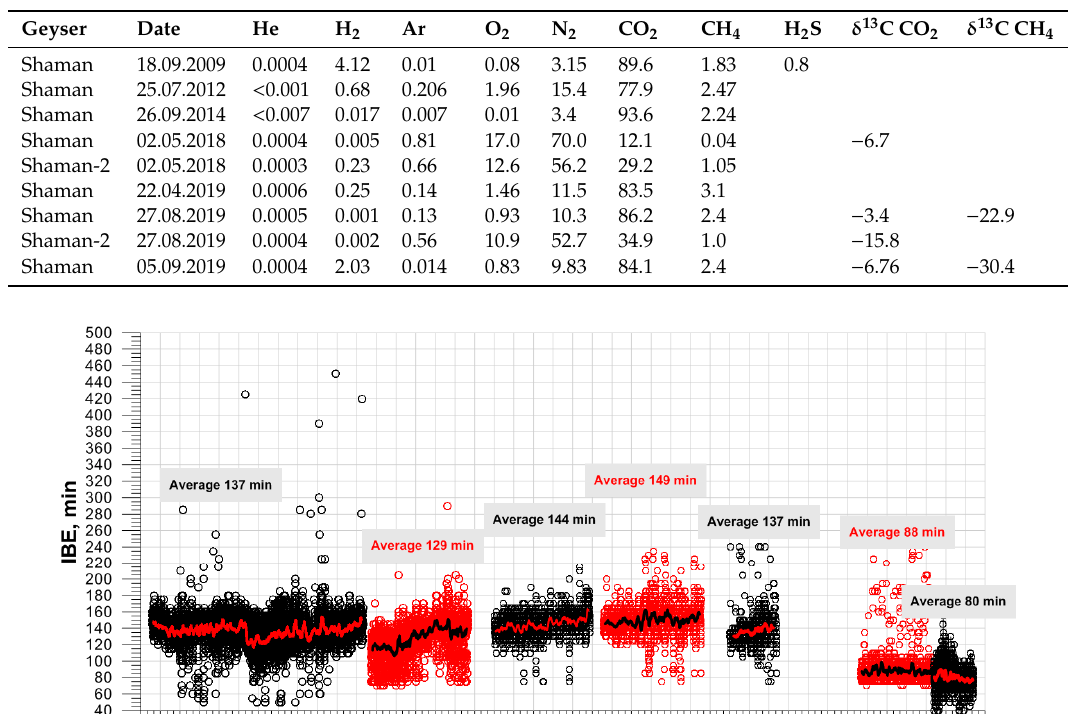
Table 2. Gas composition (vol. %) of the Shaman geyser and adjacent gas-boiling hot spring Shaman- 2 ( Figure A 11 in Appendix). Gas sampling in 2009, 2012, 2014, and 05.09.2019 was performed by G.A. Karpov, and gas sampling in 2018–2019 was performed by A.V. Kiryukhin and N.B. Zhuravlev using the sampling method (RU patent # 195670)). Chemical analysis was performed at the Central Chemical Lab. IVS FEB RAS, isotope analysis was performed by V.Y. Lavrushin and B.G. Pokrovsky in GIN RAS ( δ 13 C‰).